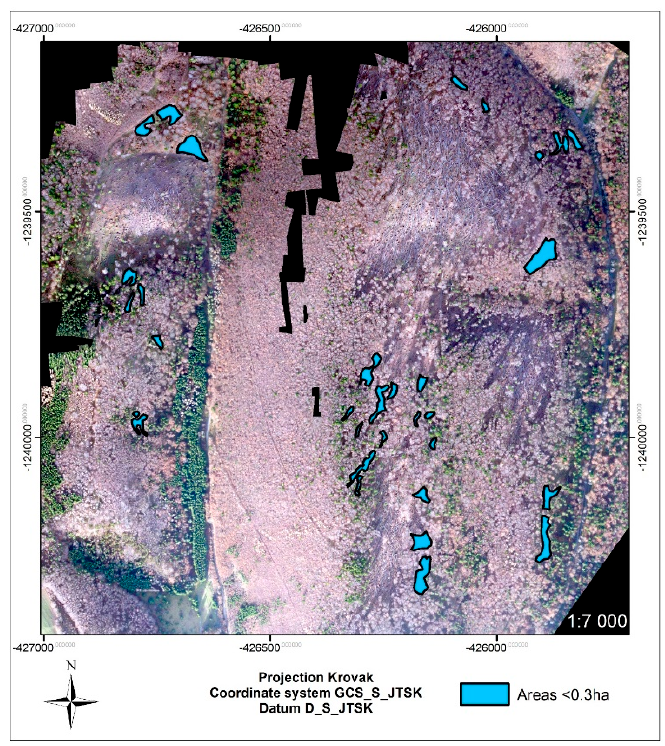
Figure 6. The view of the windthrow areas under <0.3 ha detected within the area from UAS imagery.